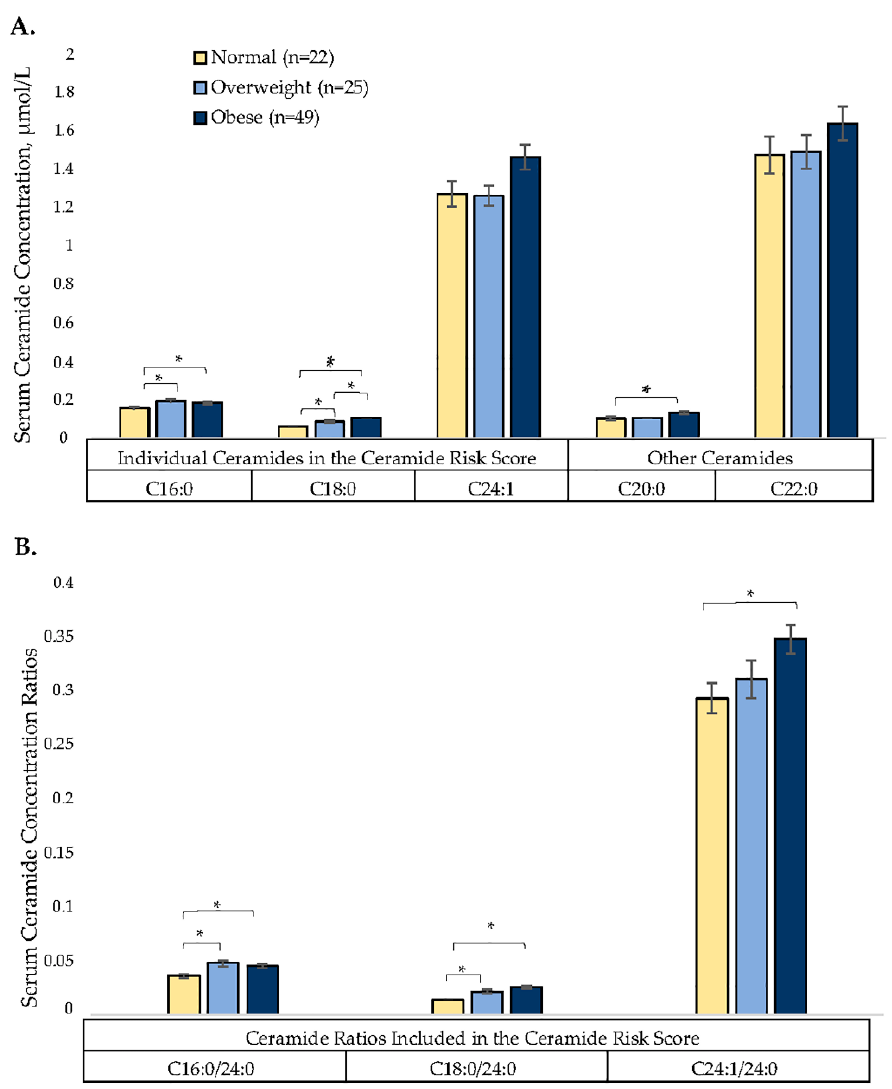
Figure 1. A. Serum ceramide concentrations (µmol/L) by BMI category: normal weight (18.5–24.9 kg/m 2 ), overweight (25–29.9 kg/m 2 ), and obese ( ≥ 30 kg/m 2 ). Values reported are mean concentrations. B. Ceramide ratios included in the risk score by BMI category. Values are means of ratios. Tukey’s honestly significant difference (HSD) was used to test significance between the three BMI categories. * Significant p -values < 0.05.